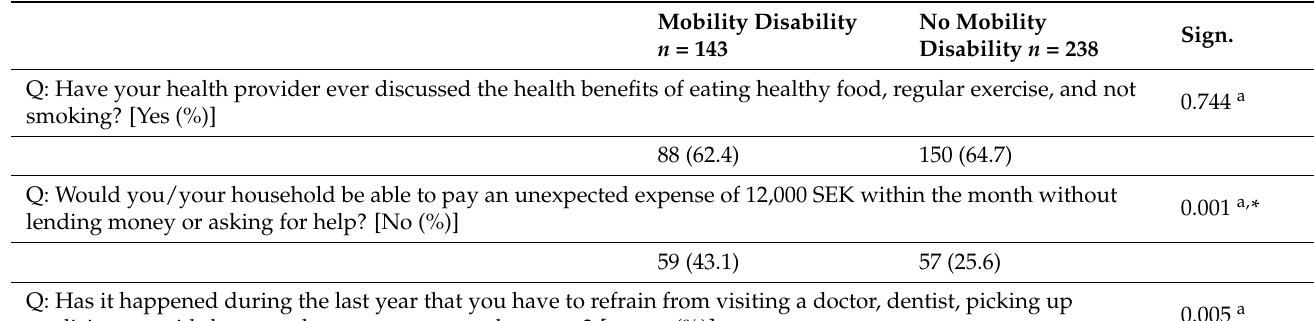
No Mobility Disability n = 238